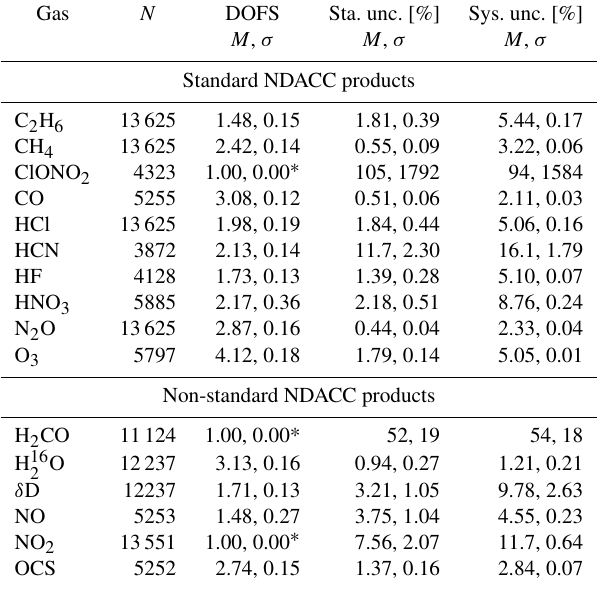
noise and the model parameter sources accounting for in- Table 3. Overview of standard and non-standard NDACC products: number of measured spectra ( N ), mean ( M ), and standard deviation ( σ ) of the total DOFS; M and σ of the statistical uncertainty (Sta. line shape – ILS – function, solar pointing, atmospheric tem- unc., in %); and M and σ of the systematic uncertainty (Sys. unc., perature profiles, solar lines, and spectroscopic parameters), in %). Note that H 16 O values correspond to the simple MUSICA which are split into statistical and systematic contributions. 2 water vapour product (refer to Sect. 4.3 of Barthlott et al., 2017), Further details about the uncertainty analysis are given in Ap- while δ D products are taken from the quasi-optimal estimation of pendix A. { H } pair data (refer to Sect. 4.4 of Barthlott et al., 2017). The 2 O ,δ D Statistics on the uncertainties for all NDACC products are ∗ refers to those trace gases evaluated using a scaling retrieval. also included in Table 3. The statistical uncertainty mean over the 20-year period (1 standard deviation, σ , in brack- ets) ranges from ∼ 0 . 4 % ( ∼ 0 . 04 %) for N 2 O up to ∼ 50